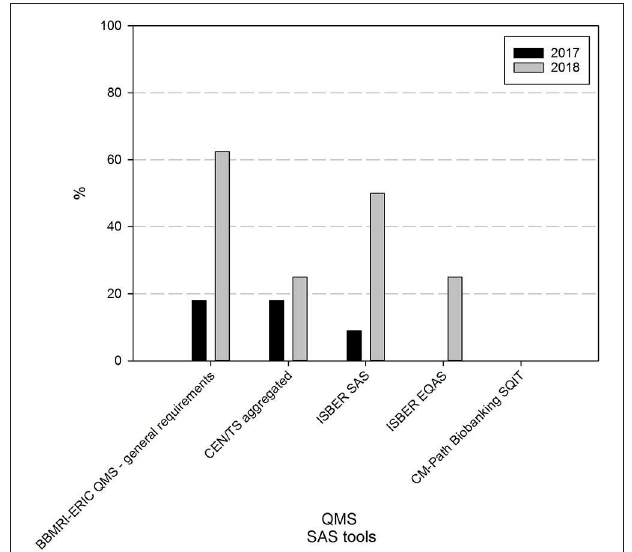
FIGURE 3 | Use of self-assessment tools in biobanks in the BBMRI.be network in 2017 and 2018. Participants were asked to indicate from a list which self-assessment survey (SAS) tools were used in their biobank to assess the status of the overall quality management system (BBMRI-ERIC QMS—general requirements and ISBER SAS), the compliance to standard specifications for pre-examination processes (CEN/TS aggregated: 10 individual SAS tools developed by BBMRI-ERIC, participation in one or more of these SAS tools was considered as 1 positive reply), the overall quality status of the pre-analytical processes (ISBER EQAS) or awareness of factors in tissue collection, processing and storage that may impact sample quality (CM Path Biobanking SQIT). Black bars indicate participants’ responses in 2017, gray bars indicate participants’ responses in 2018. CEN/TS, European Committee for Standardization Technical Standards; EQAS, pre-analytical external quality assessment survey; SQIT, CM-Path Biobanking Sample Quality Improvement Tool.